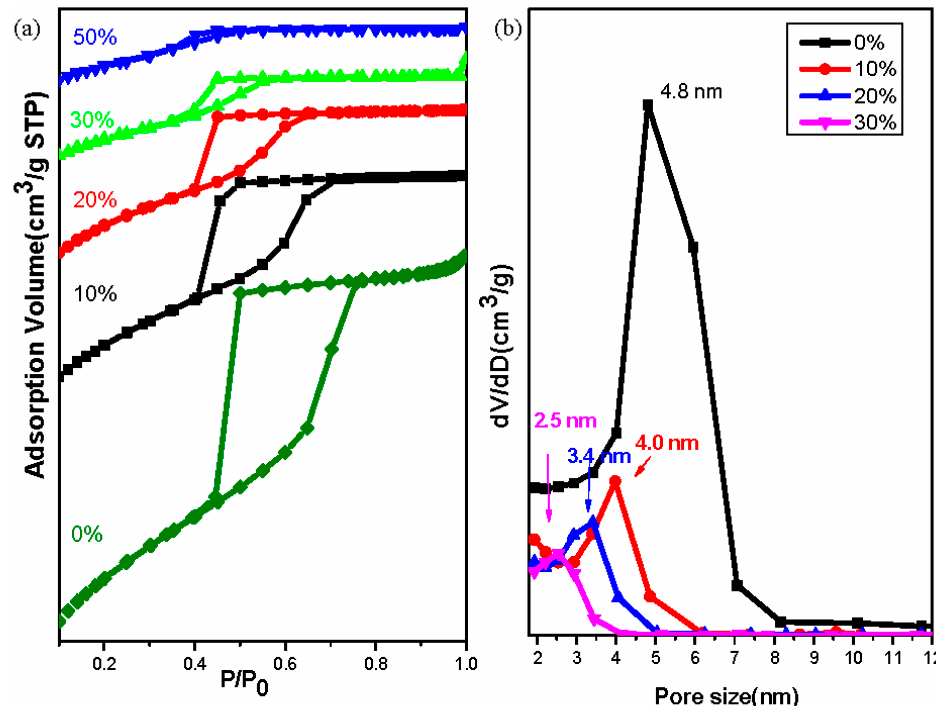
Figure 6. ( a ) N 2 adsorption/desorption isotherms; and ( b ) Pore size distribution curves